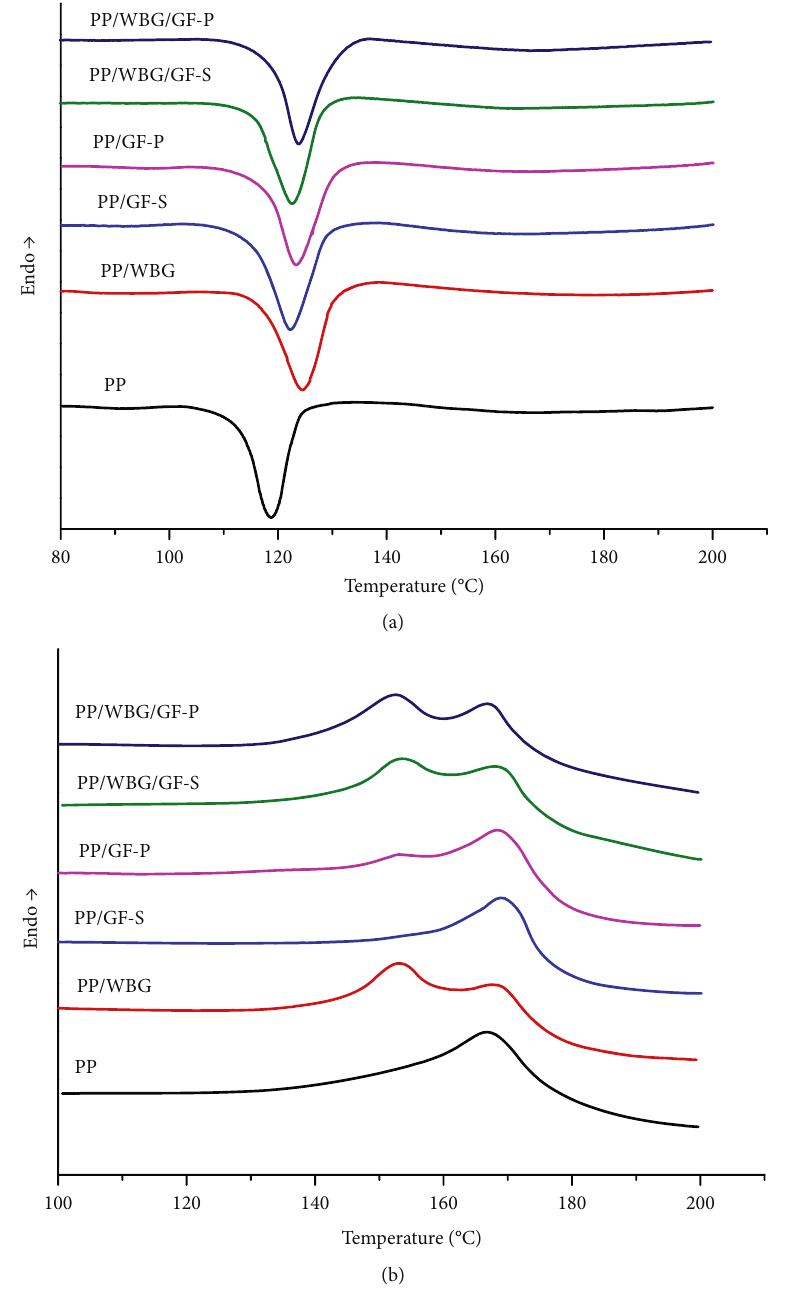
Figure 3: DSC (a) cooling and (b) heating of samples. Table 2: Crystallization and melting parameters of